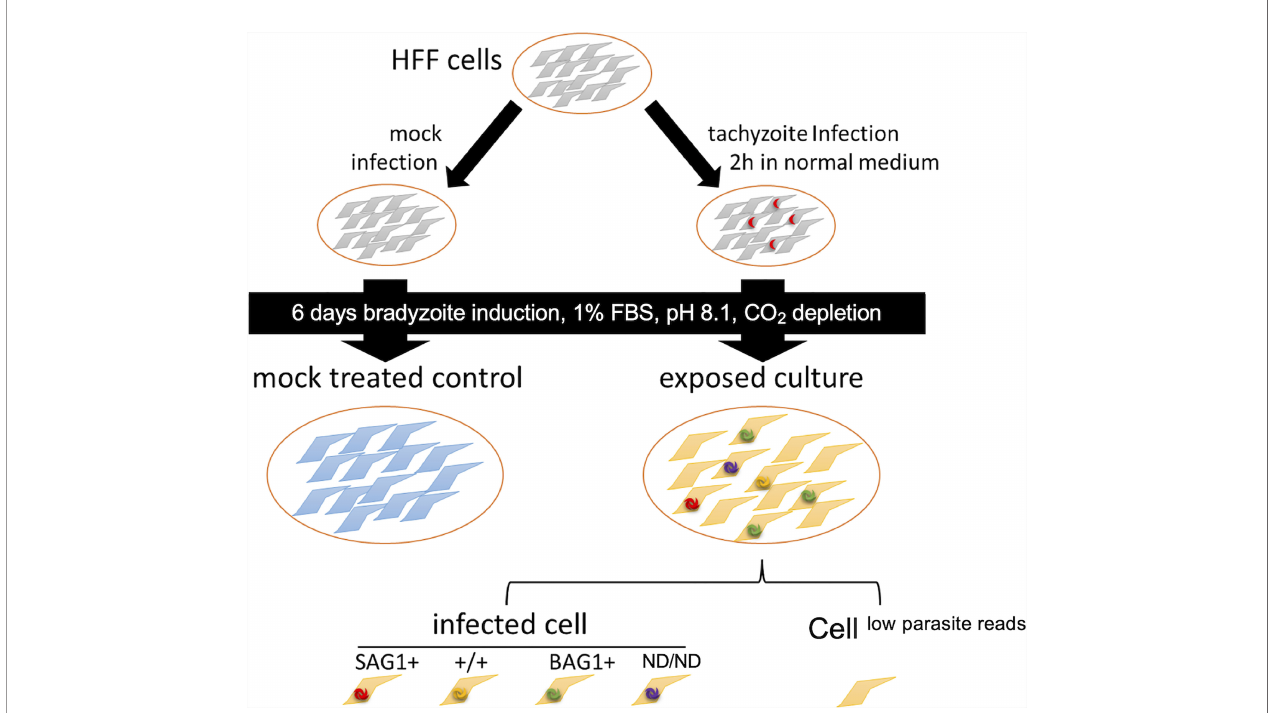
FIGURE 1 | Schematic diagram of the experimental design. For transcriptome analysis of parasite-infected cells, we prepared bradyzoite-infected cells (exposed culture) by inoculating HFF cells with tachyzoites, followed by the induction of bradyzoite differentiation for 6 days in bradyzoite induction medium without CO 2 addition. As a control, HFFs without parasite inoculation were incubated under the same conditions for 6 days (mock-infected treated control). In the exposed culture, the cells were assigned to each category based on the mRNA molecules detected. Parasite-mapped mRNA molecules (parasite load) were used to infer the infection status, and the cells were divided into infected cells and others (cells low parasite reads ). Infected cells were further assigned to different subsets based on the presence of the canonical tachyzoite marker SAG1 and bradyzoite marker BAG1 (SAG1+: cells with T. gondii SAG1+/BAG1 − , +/+: cells with both BAG1 and SAG1 markers were detected, BAG1+: cells with T. gondii SAG1 − /BAG1+ , ND/ND: cells with T. gondii , but both SAG1 and BAG1 markers were below the detection